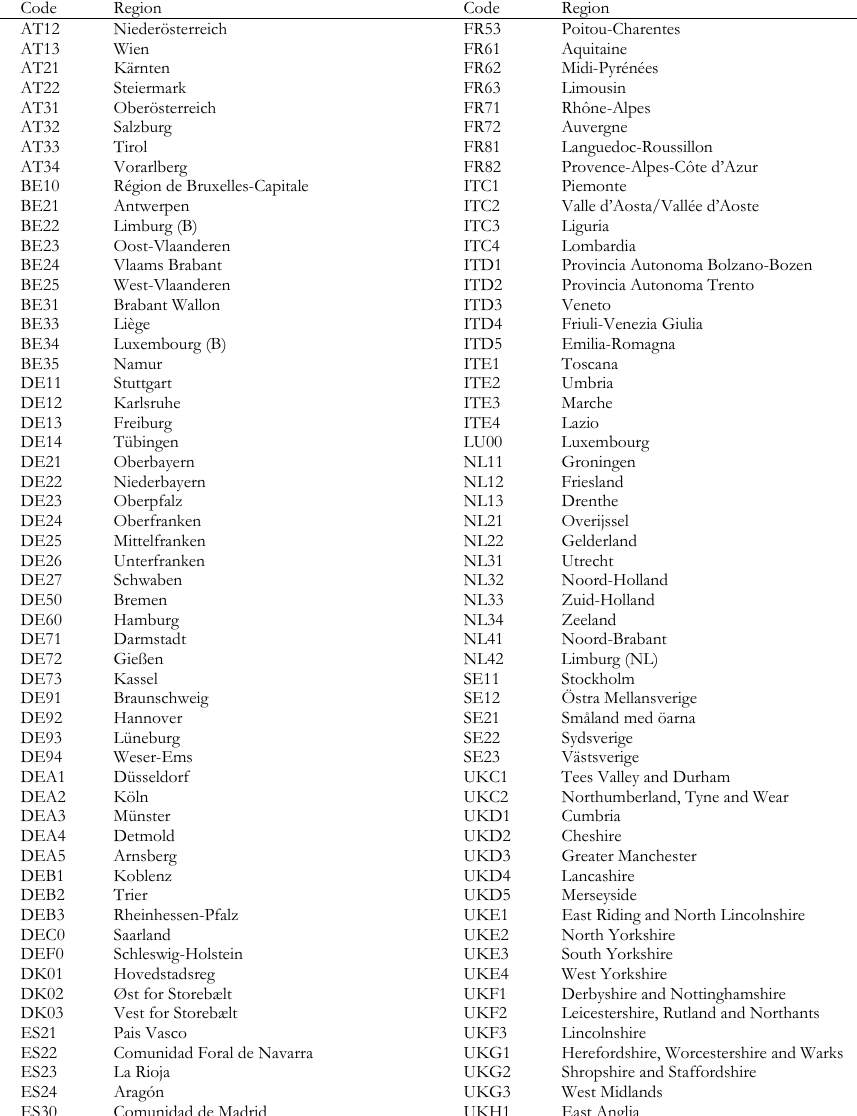
List of NUTS-2 non-Objective 1 regions included in the